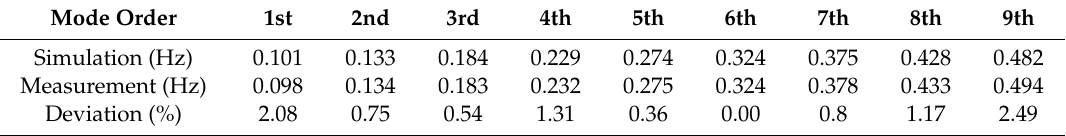
Table 3. Comparison between analytical and identified modal frequencies of XHM Bridge.